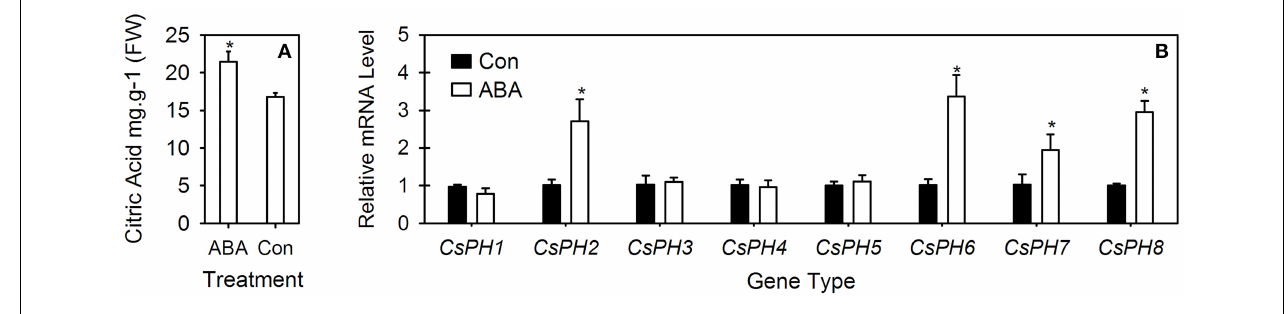
indicates significant differences between the ABA treatment and control (Con) for citric acid or each gene at P < 0 . 05 based on Student’s t -test